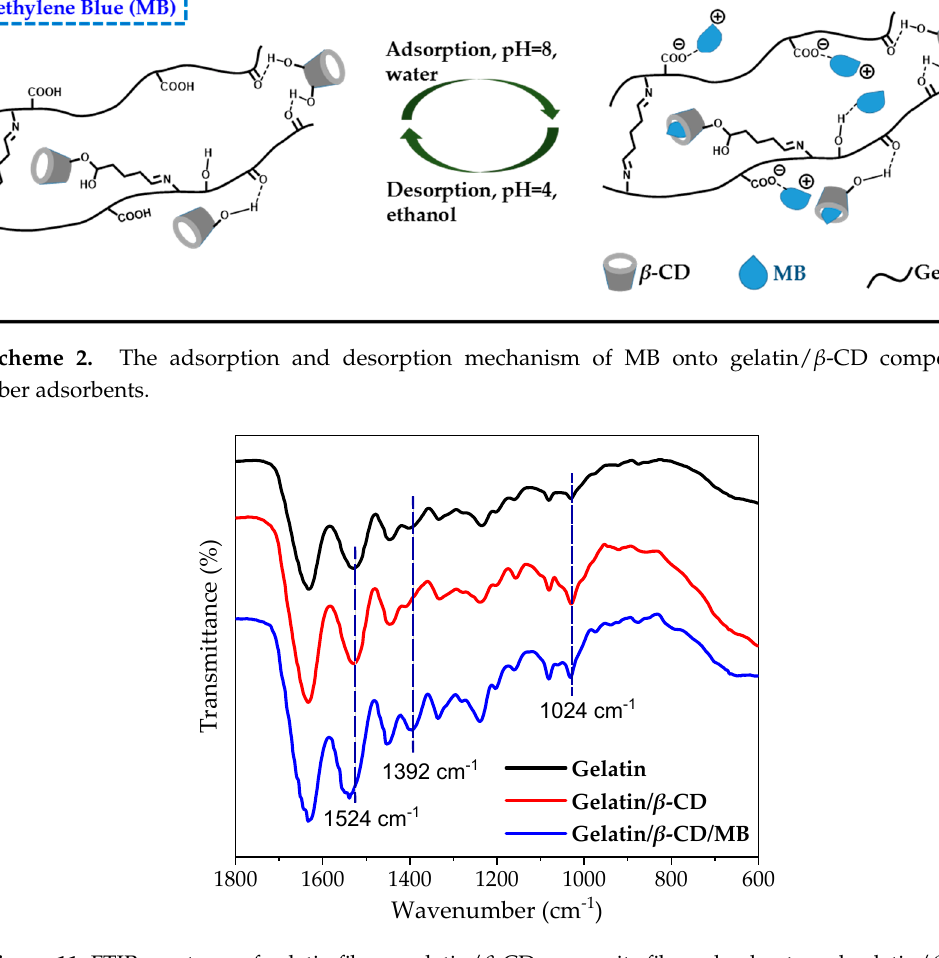
Figure 11. FTIR spectrum of gelatin fibers, gelatin/ β -CD composite fiber adsorbents and gelatin/ β -CD composite fiber adsorbents with MB adsorption.